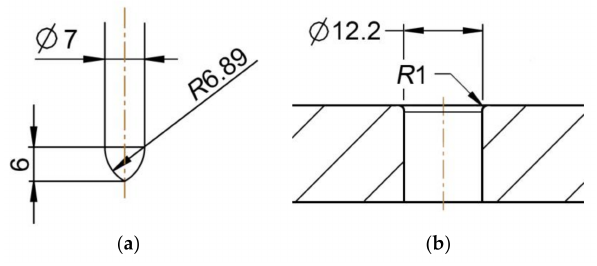
Figure 1. The geometry of hole-flanging forming die: ( a ) Punch; ( b ) die.